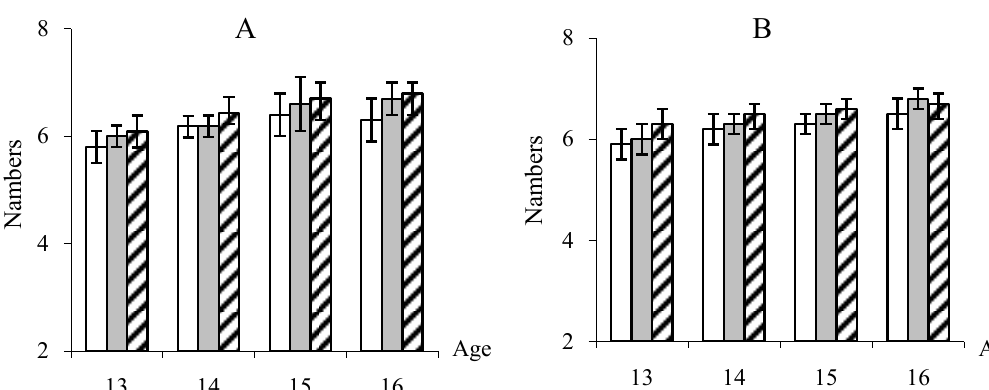
Fig.1. Short-Term Memory Amount for Numbers among Boys (A) and Girls (B) Aged 13-16 with - High, - Middle, - Low Level of Physical